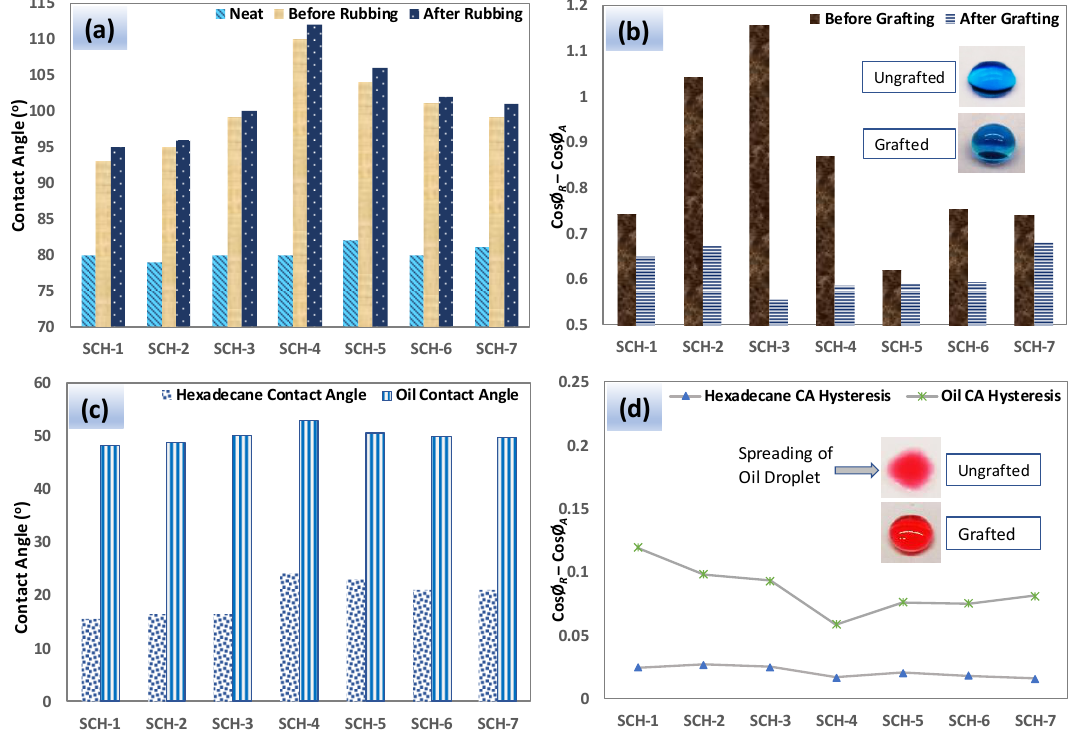
Figure 6. Water contact angles ( a ) and water contact angle hysteresis values ( b ) on various PU surfaces. Also shown are hexadecane and oil contact angle ( c ) as well as Hexadecane and oil contact angle hysteresis values ( d ) on various PDMS-treated PU coatings. Hexane and vegetable oil readily spread on the neat PU coatings and thus the plots shown in ( c ) and ( d ) refer only to the PDMS-bearing coatings.